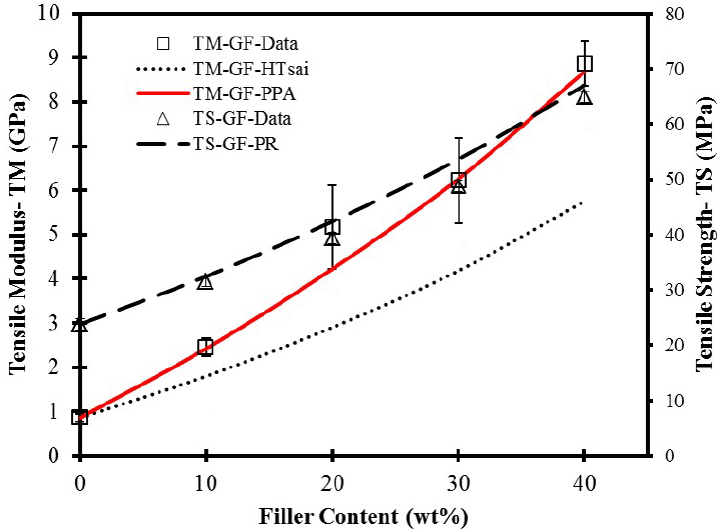
Figure 2. Tensile properties of GF-filled HDPE AD60 composites. Line showing predicted (PR) values with various